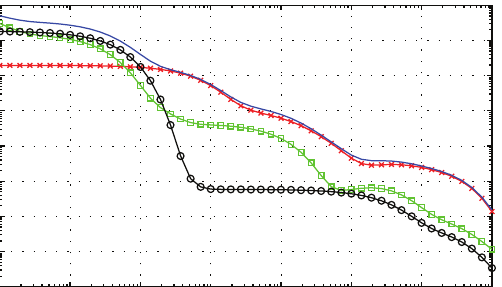
Figure 29: Contributions to heatload versus time—GCFR SNF end fourth cycle.